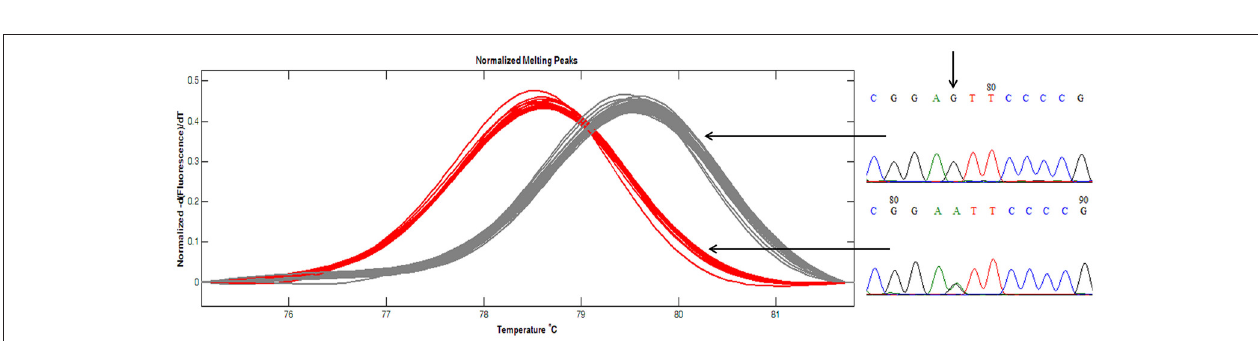
FIGURE 4 | Amplicon melting analysis of ampilcon EST-66. A total of 96 peanut varieties were analyzed by HRM in ampilcon EST-66. Of the 96 varieties, 28 samples showed red line, and remaining 68 samples showed in gray lines. Representative sequence traces were shown on the right; homozygote at the top and heterozygote at the bottom. Vertical arrows showed the SNP position.